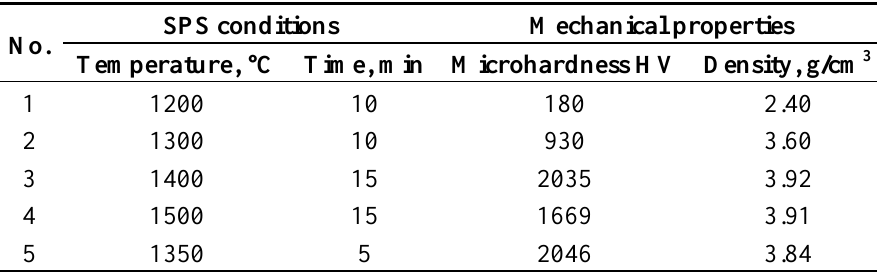
Table 4. Microhardness and density of the SPS-ed